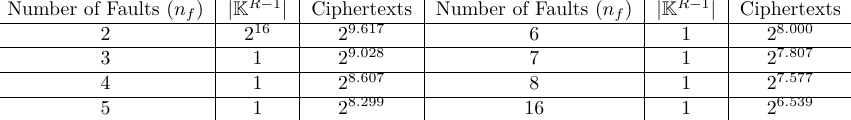
Table 4: The required number of faulty ciphertexts of AES-128.